Question: From the figure, is the trend upward or downward?
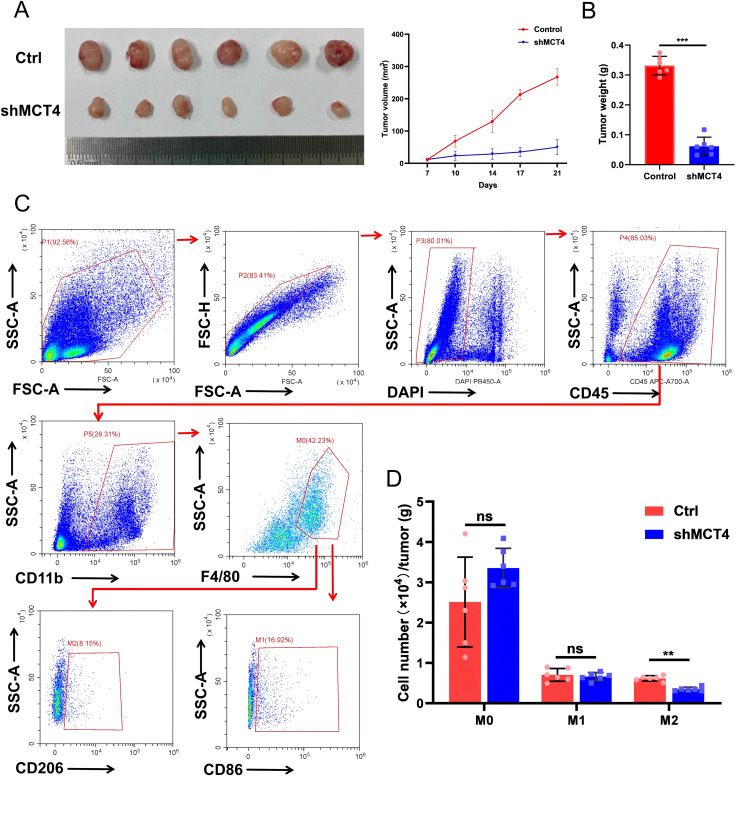
Answer: increasing